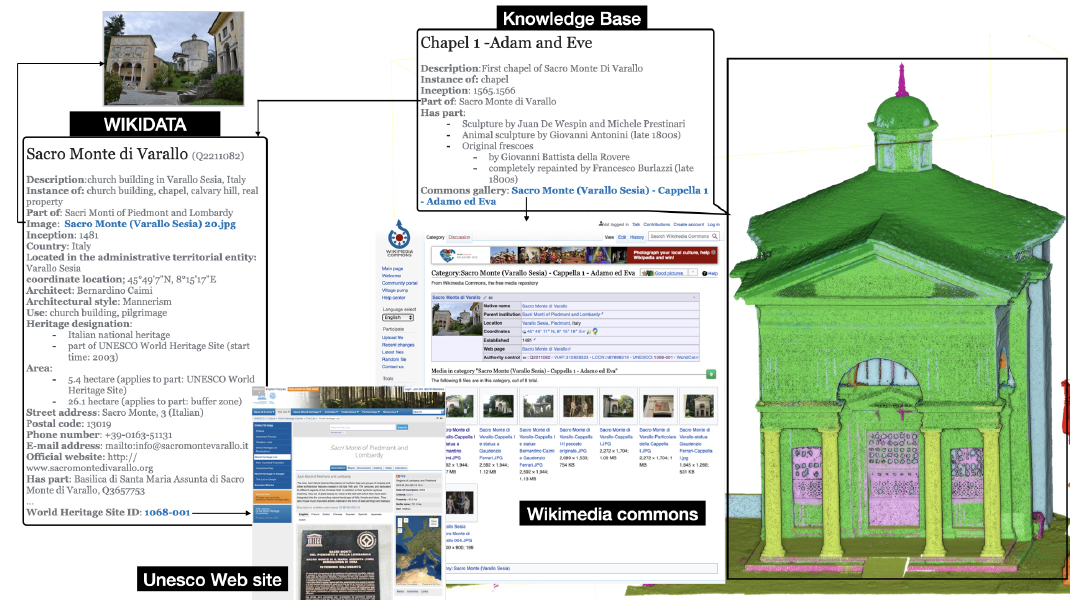
Figure 13. Enriched cultural heritage information related to the chapel.